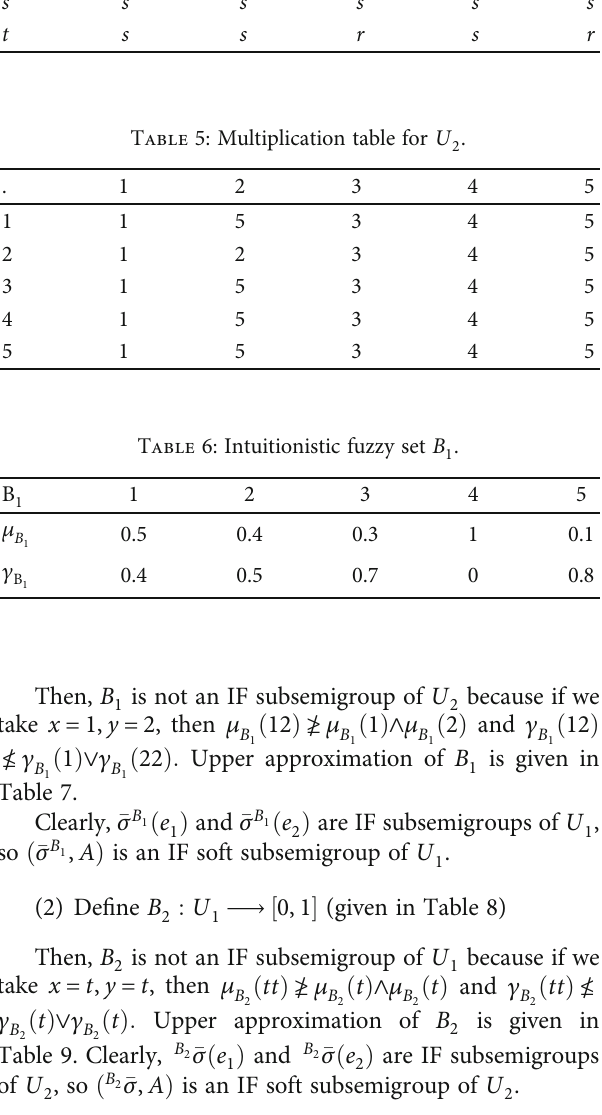
Table 4: Multiplication table for U .